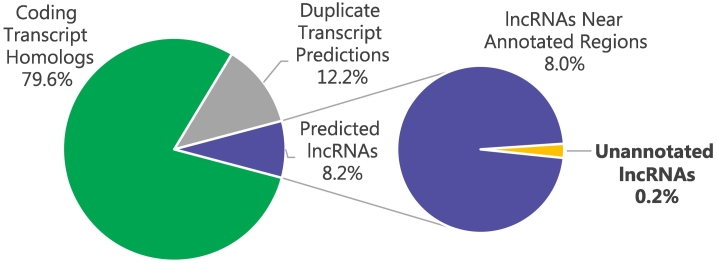
Reconstructed transcripts were compared to known coding transcripts in human and mouse showing that around 8% of transcripts in the model shared no homology and were likely noncoding. This class of molecules, i.e., lncRNAs, is of particular interest because they are relatively uncharacterized and known to be associated with prostate cancer [11]. A small portion of these putative lncRNAs was particularly interesting in that they were near no other annotations in the reference gene model, thus representing novel transcripts. These results allowed us to prioritize for further investigation several lncRNAs that differentiated aggressive and indolent cancers.